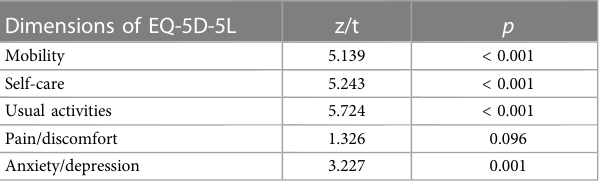
TABLE 4 Subdimensionscores of EQ-5D-5L. Values are shown as Mean±SD. Dimensions of